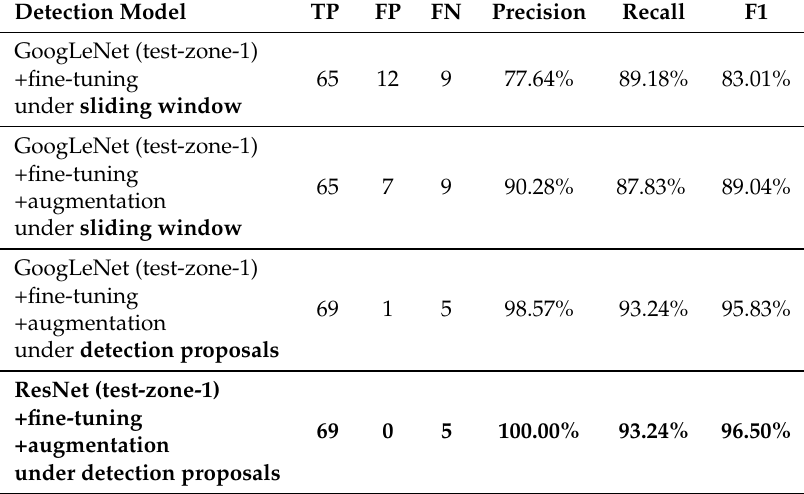
Table 2. GoogLeNet(with and without data-augmentation) and ResNet-detection results for Ziziphus lotus shrubs mapping in Test-zone-1, under the sliding window approach and using a detection-proposals approach. Accuracies are expressed in terms of true positives (TP), false positives (FP), false negatives (FN), precision, recall, and F1 measure. The highest accuracies are highlighted in bold.